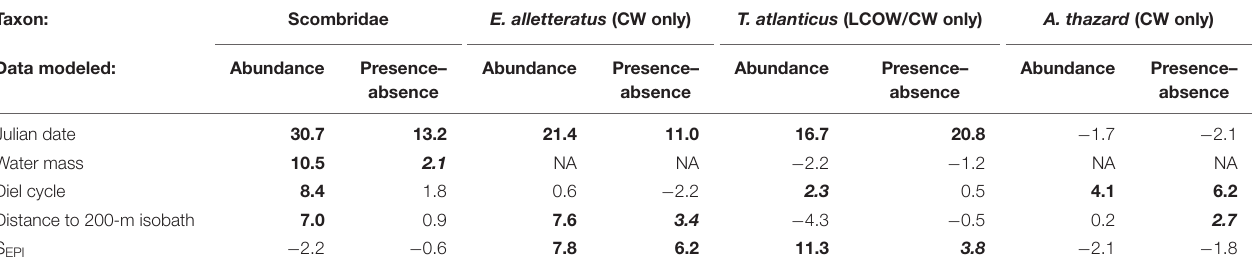
TABLE 3 | dAICc values of abundance and presence–absence GAMs after dropping each explanatory variable for Scombridae, Euthynnus alletteratus , Thunnus atlanticus , and Auxis thazard .